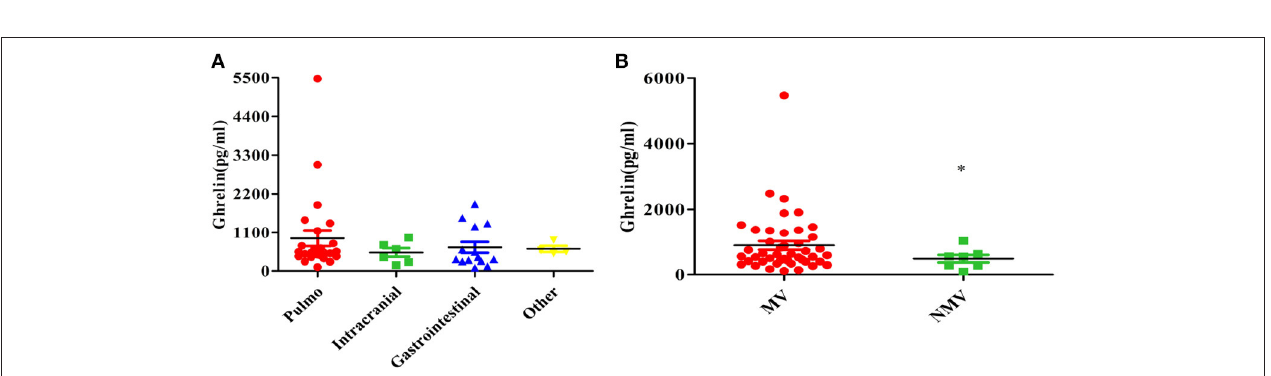
FIGURE 4 | Relationship between the plasma ghrelin level and other clinical factors in patients with sepsis. (A) Primary infection. (B) Mechanical ventilation. * p < 0.01. MV, mechanical ventilation; NMV, no mechanical ventilation.